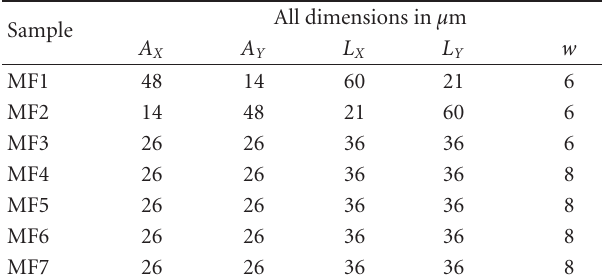
Table 1: Unit cell dimensions.